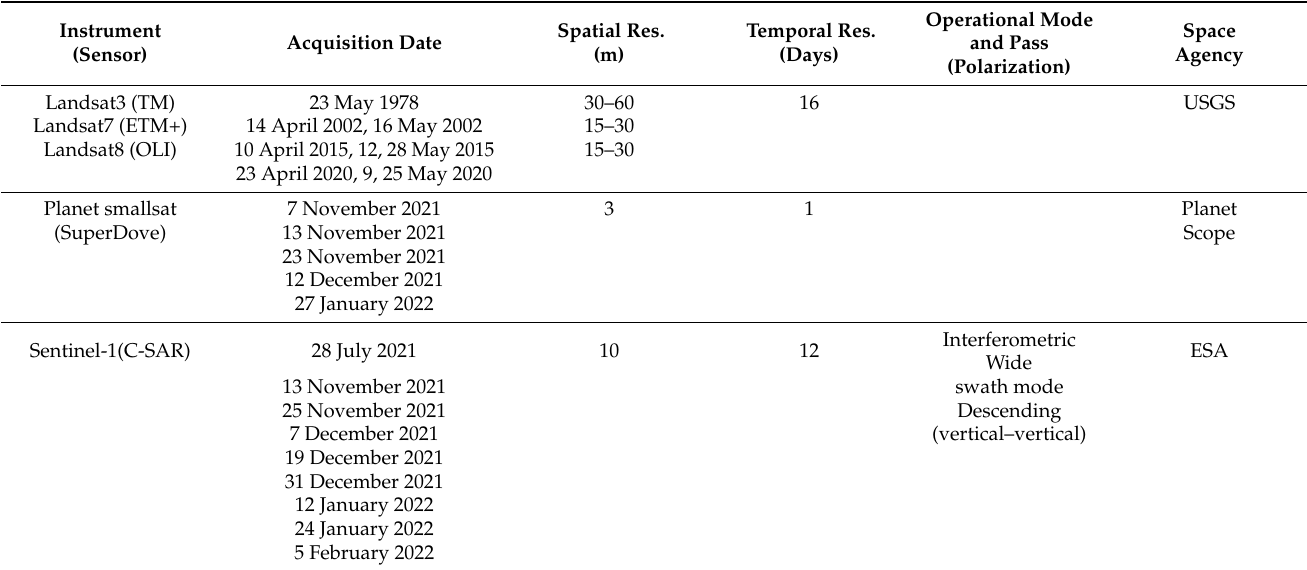
Table 1. Main specifications of the satellite imagery used in the